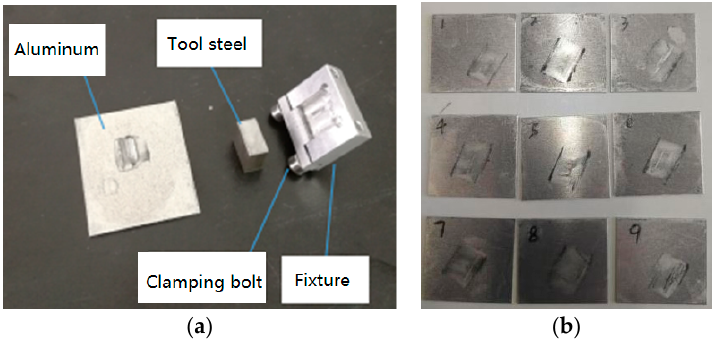
Figure 1. Diagram of the friction test sample. ( a ) Friction objects; ( b ) Aluminum plate samples.